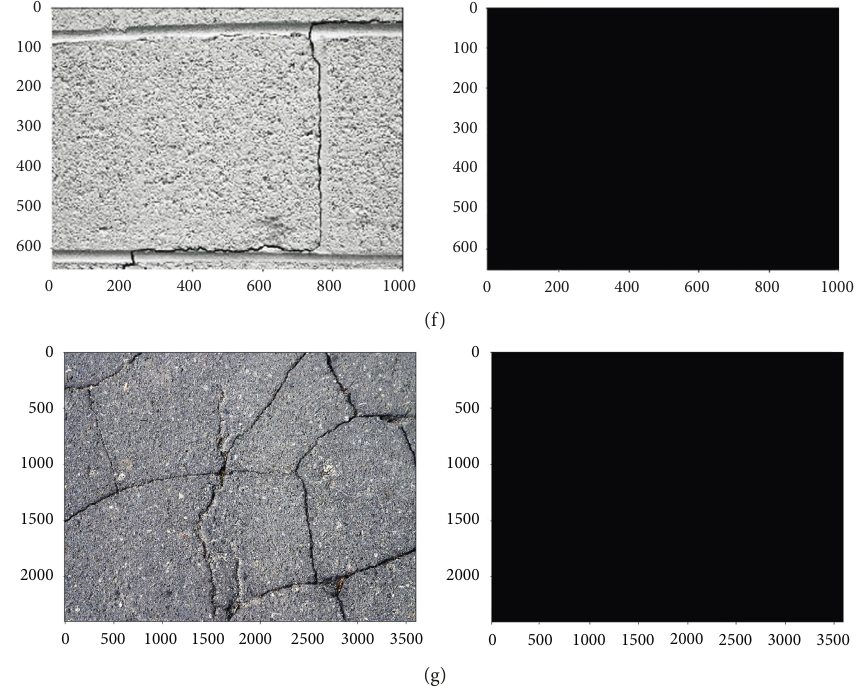
Figure 6: Crack recognition effect